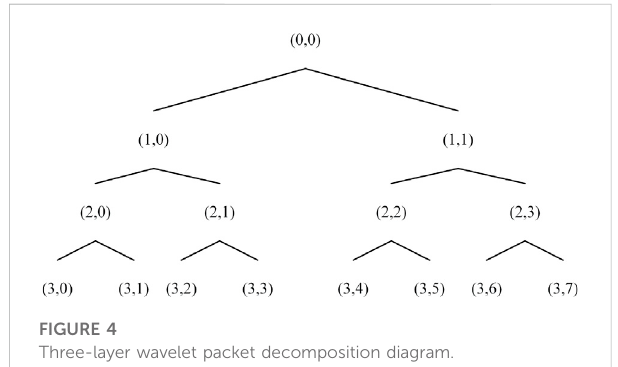
FIGURE 4 Three-layer wavelet packet decomposition diagram.